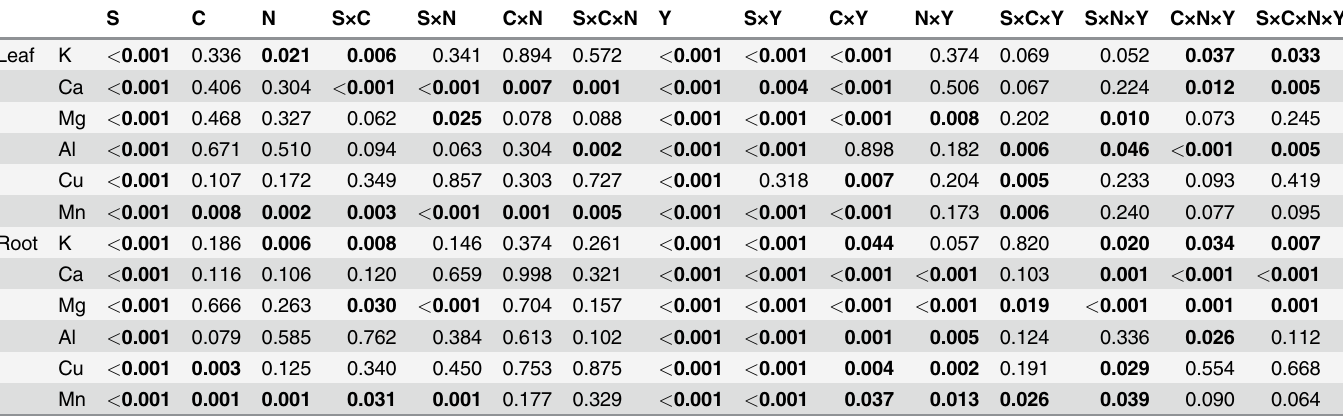
Table 2. Results ( P -value) from repeated measures ANOVA on the effects of different species (S), carbon dioxide (C) and nitrogen (N) treatments and their interactions on the concentrations of mineral elements of fi ve subtropical tree species.